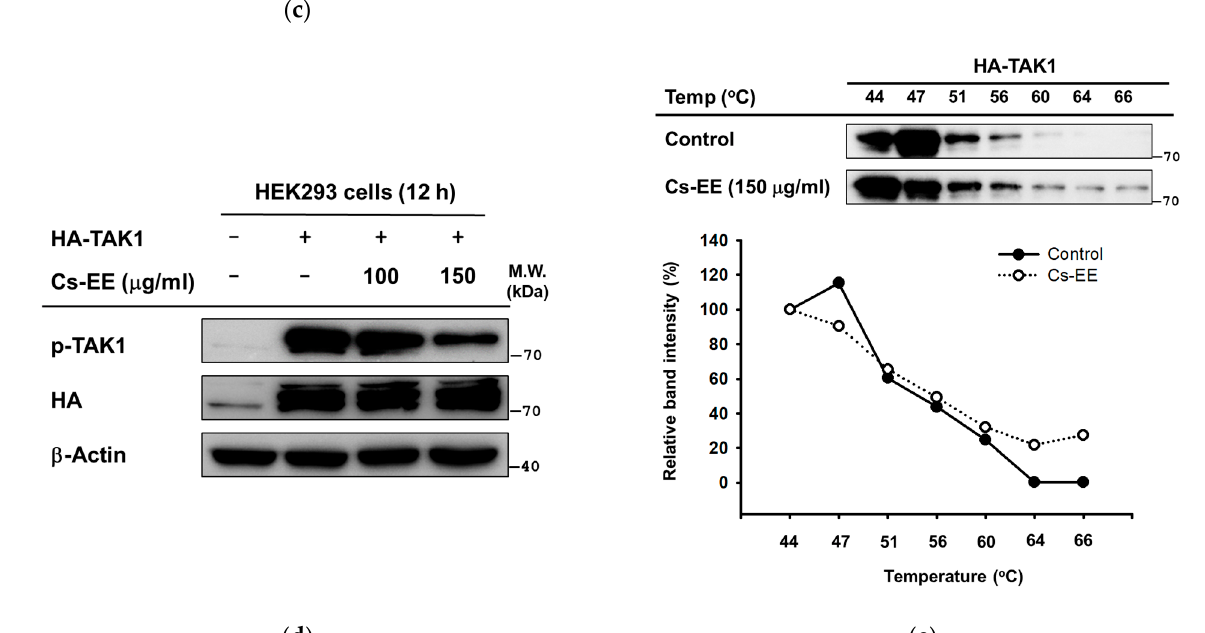
Figure 5. Effects of Cs-EE on the signaling events upstream of AP-1 activation. ( a – c ) RAW264.7 cells were pre-treated with 150 μ g/mL Cs-EE for 30 min, followed by the presence or absence of LPS at certain time points. The phosphorylated and total protein levels of JNK, ERK, p38, MKK4/7, MEK1/2, TAK1, IRAK1/4, and β -actin were evaluated by immunoblot analysis. ( d ) The phosphorylation of TAK1 was evaluated in HEK293 cells following overexpression of TAK1 by